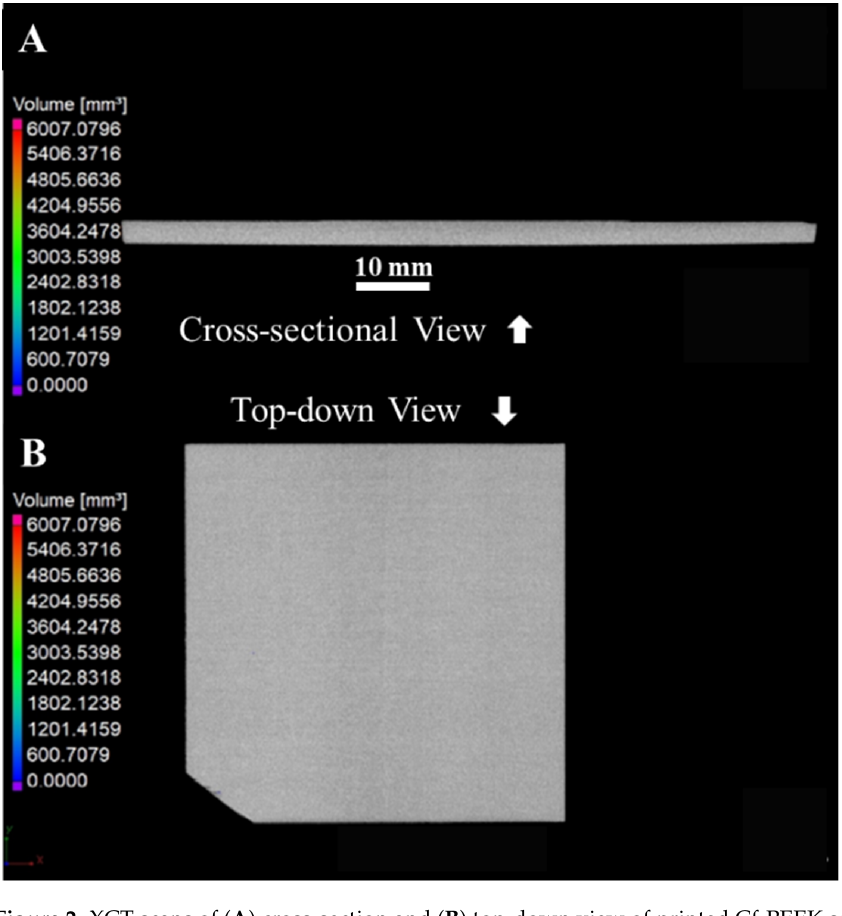
Figure 2 . XCT scans of ( A ) cross ‐ section and ( B ) top ‐ down view of printed Cf ‐ PEEK sample. Figure 2. XCT scans of ( A ) cross-section and ( B ) top-down view of printed Cf-PEEK sample.